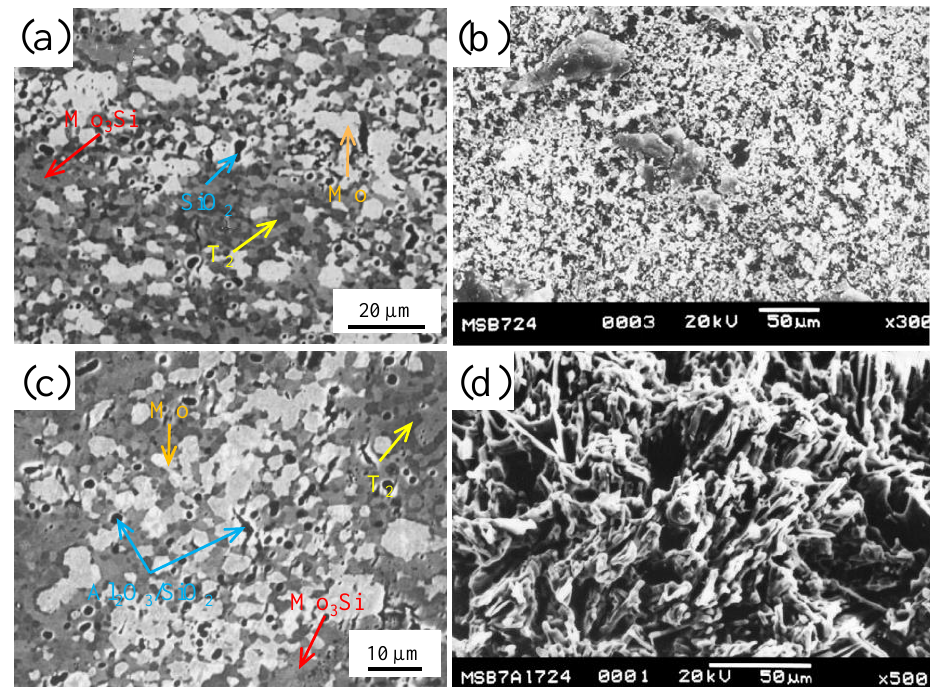
Figure 13. BSE images of the Mo-14Si-10B alloy ( a ) and Mo-11.2Si-8.1B-7.3Al alloy ( c ) before the oxidation; Surface SE images of Mo-14Si-10B alloy ( b ) and Mo-11.2Si-8.1B-7.3Al alloy ( d ) after oxidation at 700 °C for 24 h. ( a – d ) reproduced with permission [64,65], respectively. Copyright 2006 Elsevier and 2007 Elsevier.